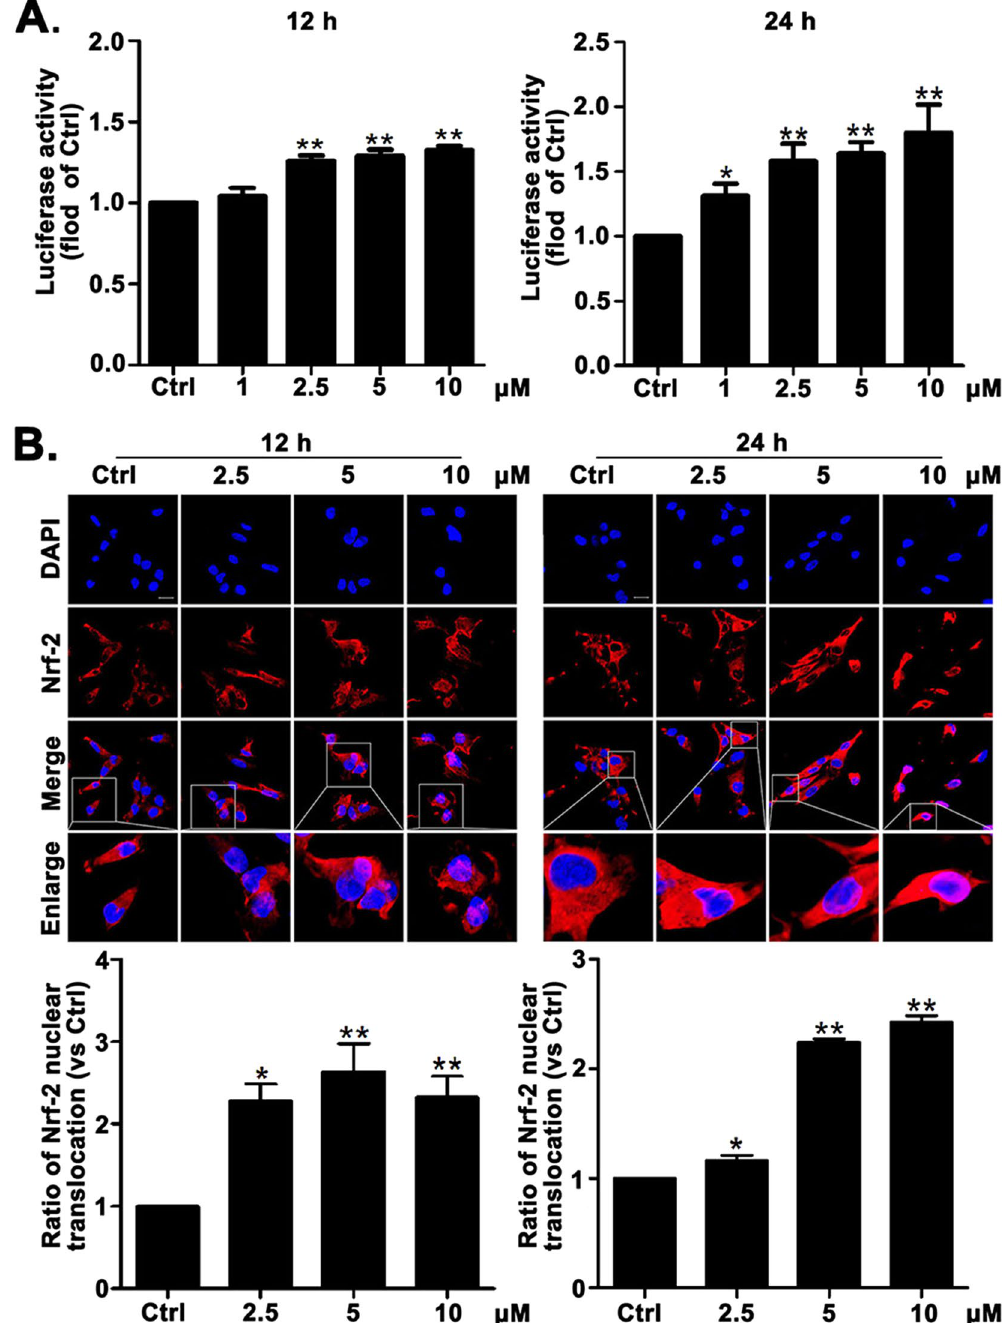
Figure 5. Effects of compound 3d on Nrf-2 activity and nuclear translocation. HeLa cells which contain Nrf-2- responsive/pGL4-3 × ARE-basic luciferase reporter vector were treated with compound 3d at 1, 2.5, 5, 10 μ M for 12 h or 24 h. The control group (Ctrl) was treated with 0.1% DMSO (V/V). Luciferase activity was determined by luciferase assay, and normalized to cell viability measured by SRB assay ( A ). Immunofluorescence staining showing Nrf-2 nuclear translocation increased after treated with compound 3d at 2.5, 5, 10 μ M for 12 h or 24 h ( B ). Scale bar: 20 μ m. Results are mean ± SEM ( * p < 0.05, ** p < 0.01 vs control. N =